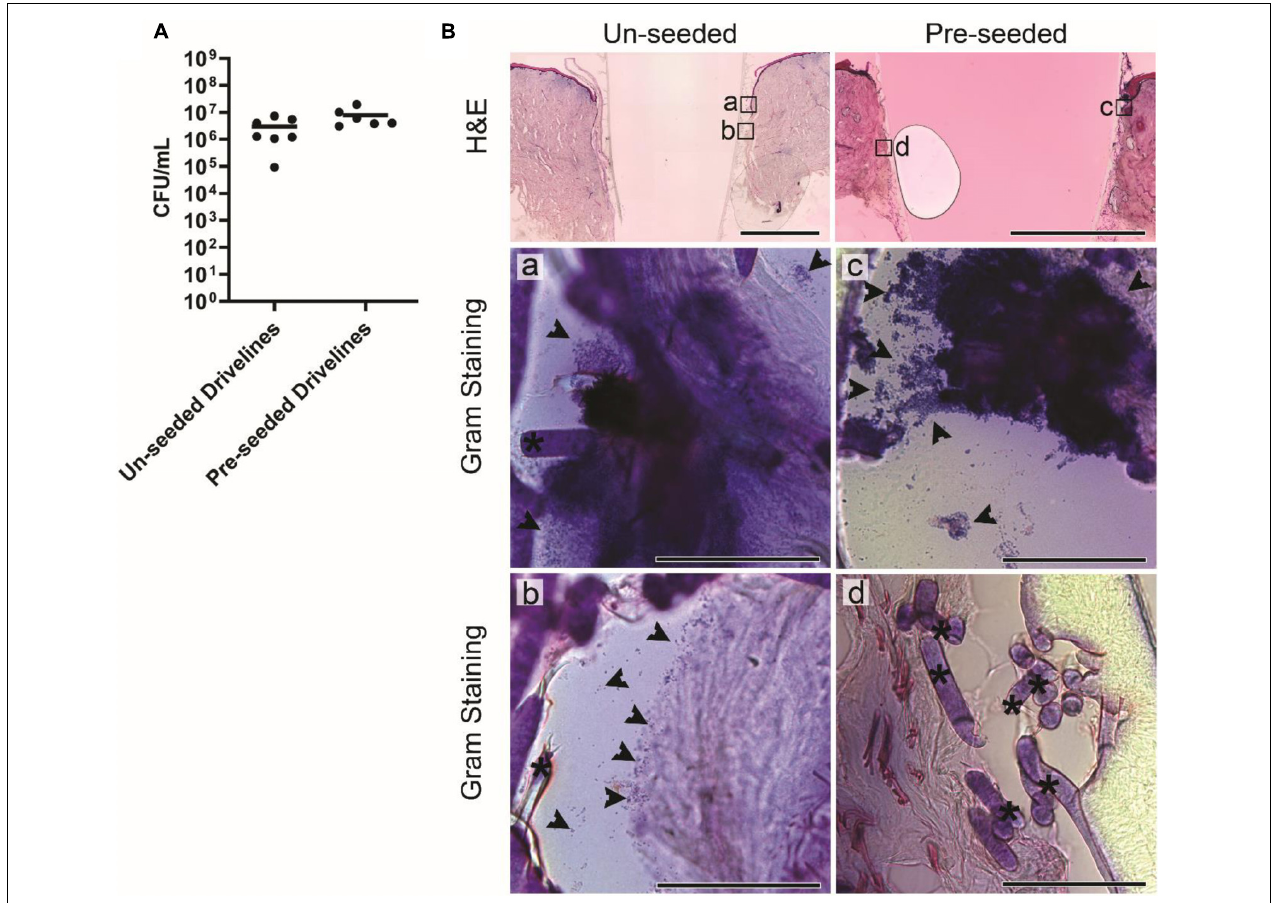
FIGURE 5 | Staphylococcus aureus infection of HSEs implanted with porous drivelines. (A) Number of viable S. aureus recovered from HSEs with un-seeded or pre-seeded drivelines at 24 hpi. Bacterial numbers are presented as CFU/mL with group means shown as horizontal lines. Dot plots show data from a minimum of 6 experimental repeats using HSEs derived from 3 donors. (B) Histological analysis of infected HSEs implanted with un-seeded and pre-seeded drivelines retained an intact epidermis and dermis as shown by H&E staining of cross-sections (top panels; scale bars denote 2 mm). In HSEs with un-seeded drivelines, S. aureus (indicated by black arrows) localized at the inoculation site (a), with bacteria detected further along the interface and associated with deeper HSE tissue or present in gaps between the tissue and un-seeded driveline (b; Gram staining, left panel; scale bars denote 100 µ m). In HSEs with pre-seeded drivelines, S. aureus localized at the inoculation site (c), but no bacterial colonization of the tissue in close contact with the driveline was observed (d; Gram staining, right panels; scale bars: 100 µ m). Black asterisks denote PCL fiber